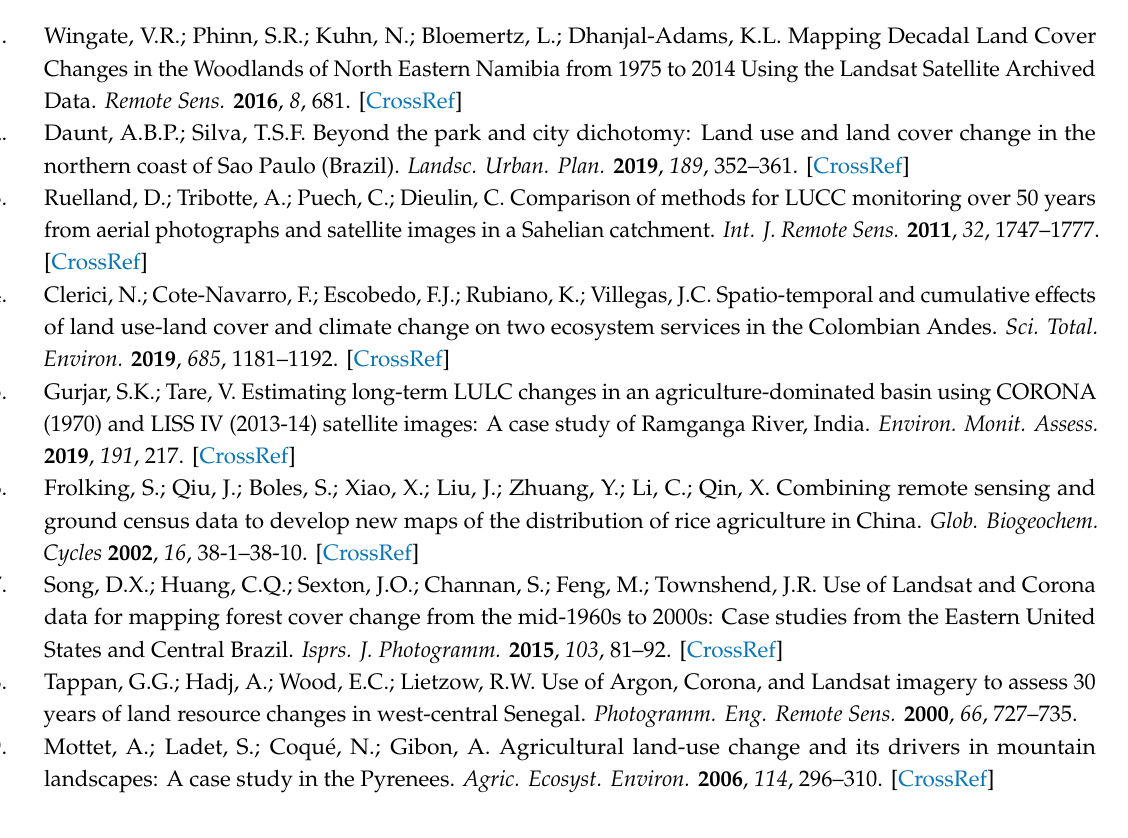
Table S1: Trajectory changes of paddy field ( > 0.02%), 1990–2015., Table S2: Trajectory changes of dry farmland ( > 0.02%),